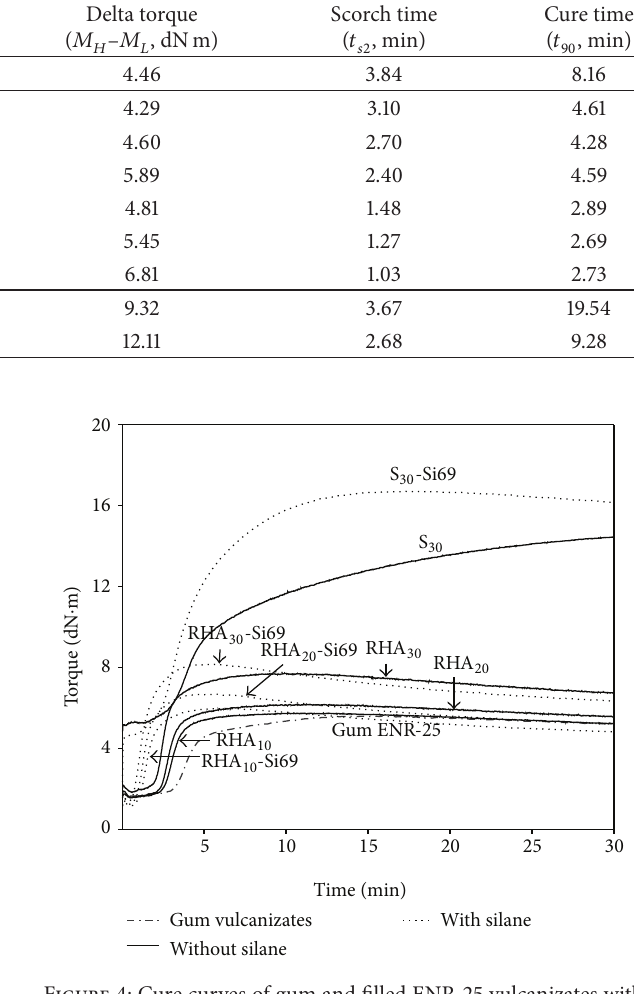
Figure 4: Cure curves of gum and filled ENR-25 vulcanizates with various contents of RHA and 30phr silica with and without silane coupling agent